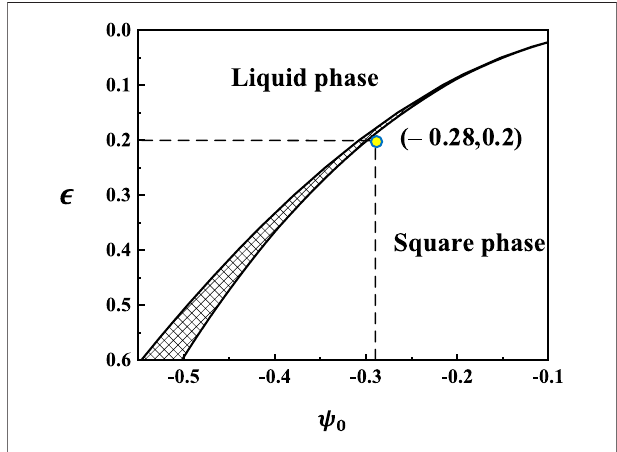
FIGURE1 | Two-dimensional phase diagram oftwo-mode approximate calculation.